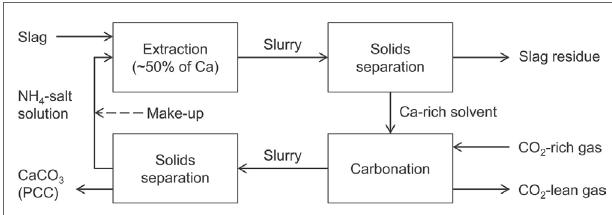
FigUre 1 | The studied concept for producing calcium carbonate from cO 2 -rich gas and slag